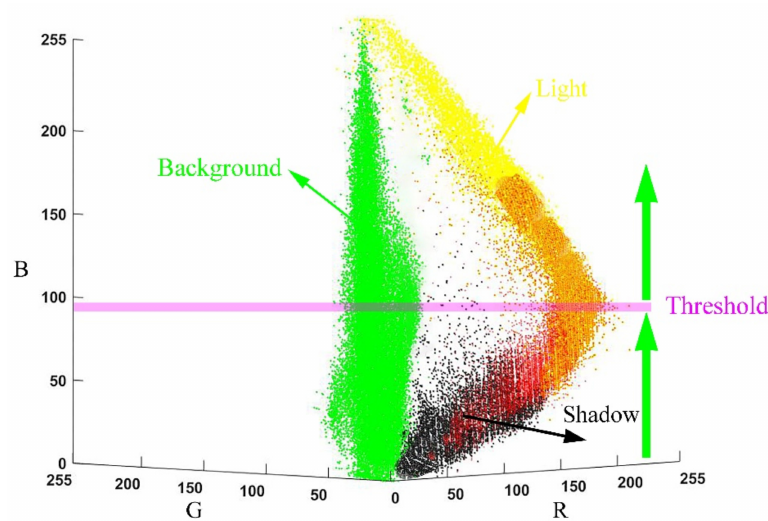
Figure 6. Selection of the B threshold.